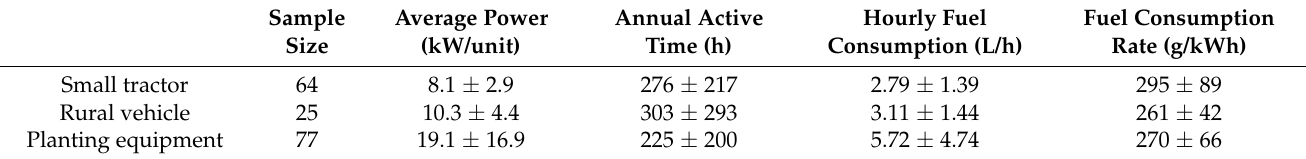
Table 3. Annual active time and fuel consumptions of three types of AM in Anhui, China.